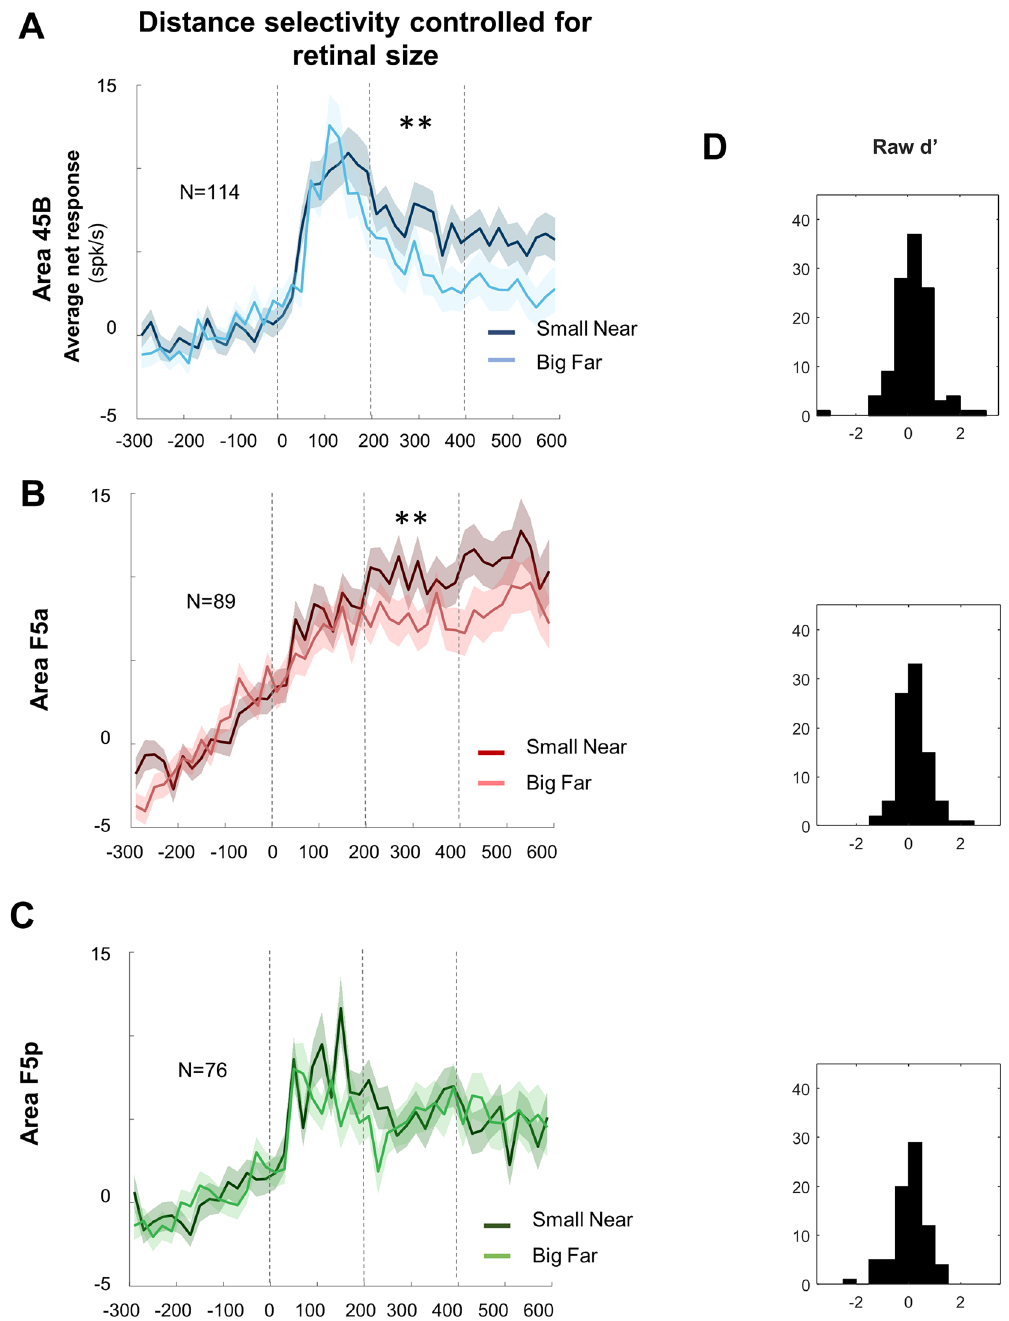
Figure 7. Distance selectivity controlled for retinal size. Average population response of objects with same retinal size for area 45B ( A ), F5a ( B ), and F5p ( C —i.e. Small Near object = Large Far object). Dark colors represent small objects presented at Near position, while lighter colors represent large objects presented at Far conditions (blue, red, and green respectively). Shadows of same color represent sem. Bin size = 20 ms. Double asterisks indicate statistical significance ( p < 0.01). See also Supplementary Fig. 4 for Monkey D and Y, separately. In ( D ) raw Retinal size selectivity d ′ distribution for area 45B, F5a and F5p